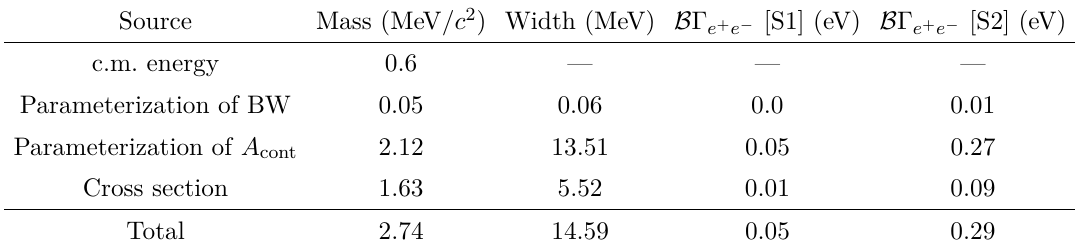
Table 8 . The systematic uncertainties for resonance parameters with the coherent sum of a BW and continuum.